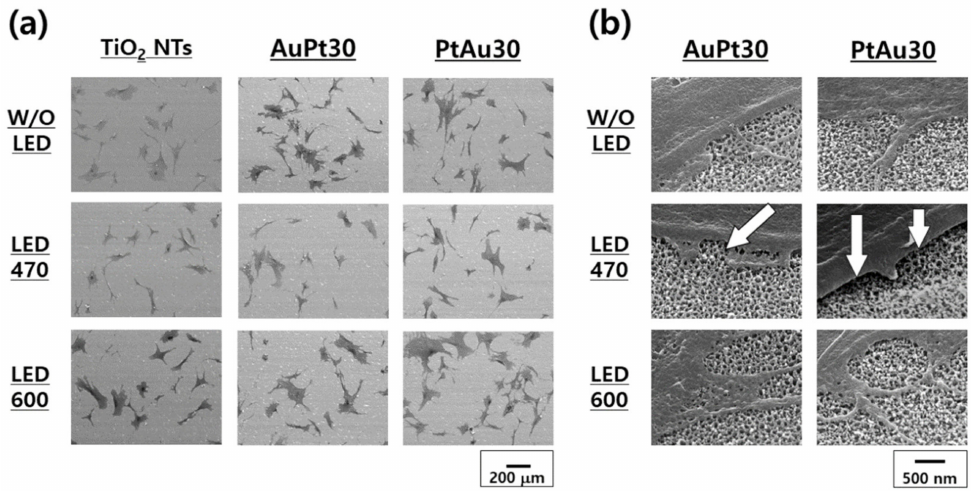
Figure 6. The morphological characterization of hMSCs cultured on Au and Pt multi-coated TiO 2 nanotubes with and without visible light irradiation (470 and 600 nm for 30 min) was observed by FE-SEM (( a ) 100 × and ( b ) 50,000 × ).